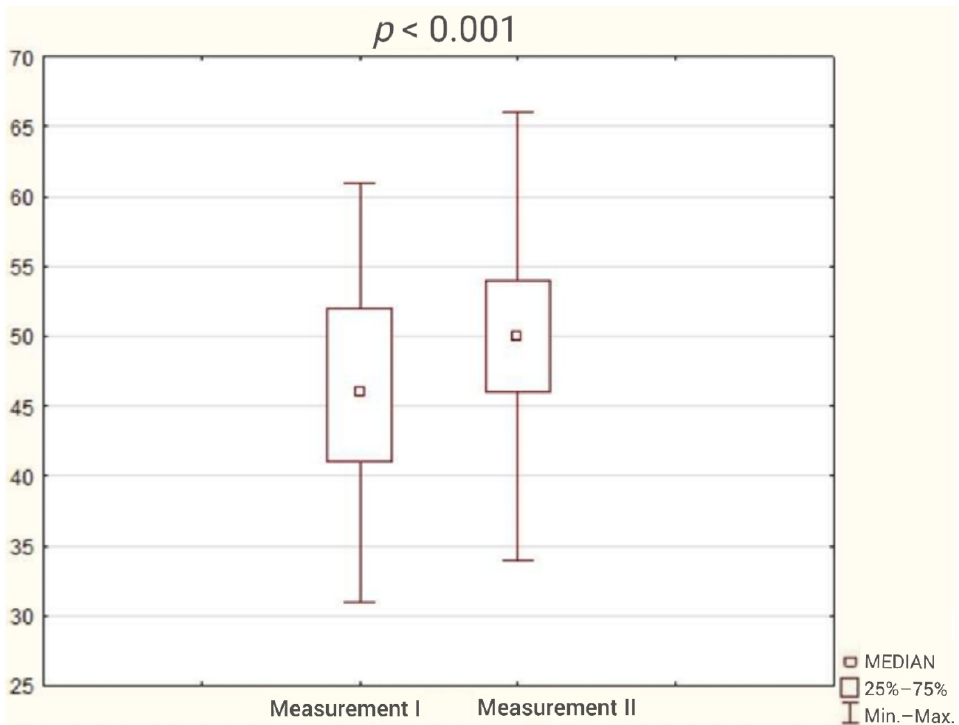
Figure 5. Patient result in Rey’s complex figure test during the first and second study (Wilcoxon test).